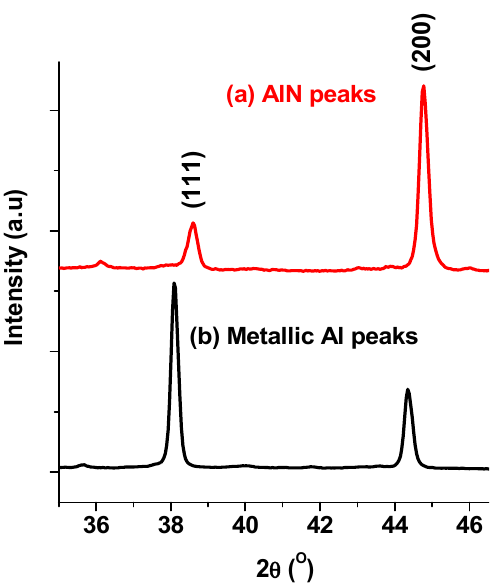
Figure 7. XRD patterns with the two major peaks used to identify AlN in the coatings, showing ( a ) AlN peaks; and ( b ) metallic Al peaks.